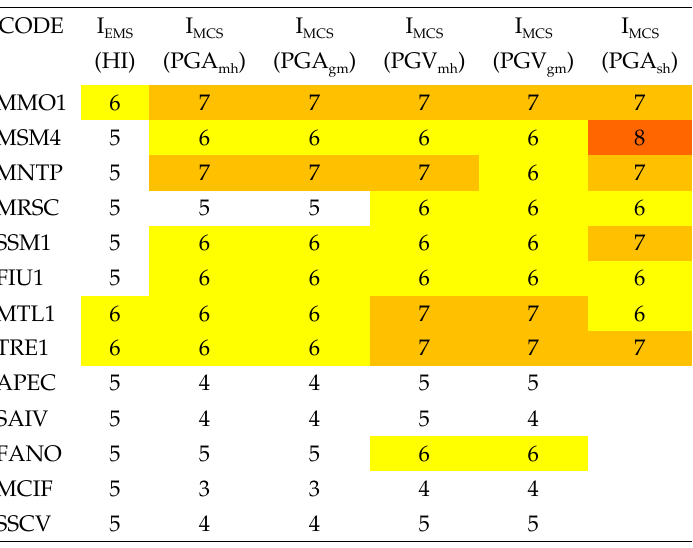
Table 3: Results of intensity estimates according to various relations. CODE: station code. I [Chiauzzi et al., 2012]. I (PGA ): intensity from maximum PGA of horizontal components [Faenza & Michelini, 2010]. MCS mh I (PGA ): intensity from geometric mean of the PGA of horizontal components [Faenza & Michelini, 2010]. I MCS gm (PGV ): intensity from maximum PGV of horizontal components [Faenza & Michelini, 2010]. I mh from geometric mean of the PGV of horizontal components [Faenza & Michelini, 2010]. I intensity obtained from shakemap in Figure 1 using Faenza & Michelini